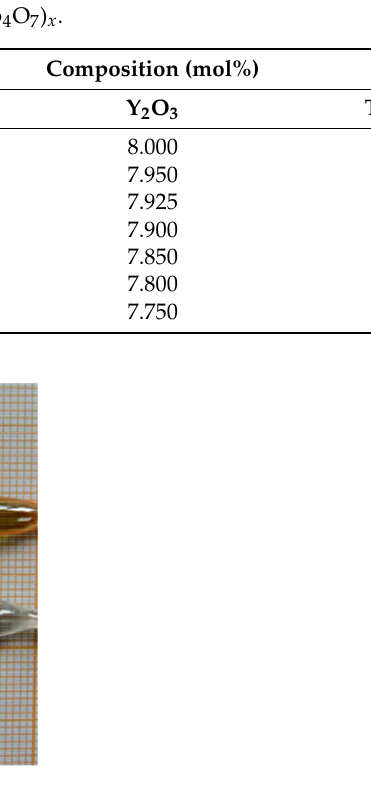
Figure 1. Photo showing the (ZrO 2 ) 92 (Y 2 O 3 ) 7.800 (Tb 4 O 7 ) 0.200 crystal rods and disks before and after annealing at 1500 ◦ C in a H 2 /Ar